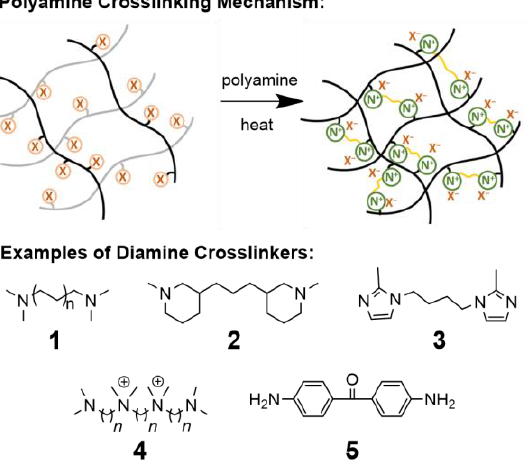
Figure 10. The Menshutkin reaction mechanism as well as diamine monomers used in AAEM cross- linking synthesis.